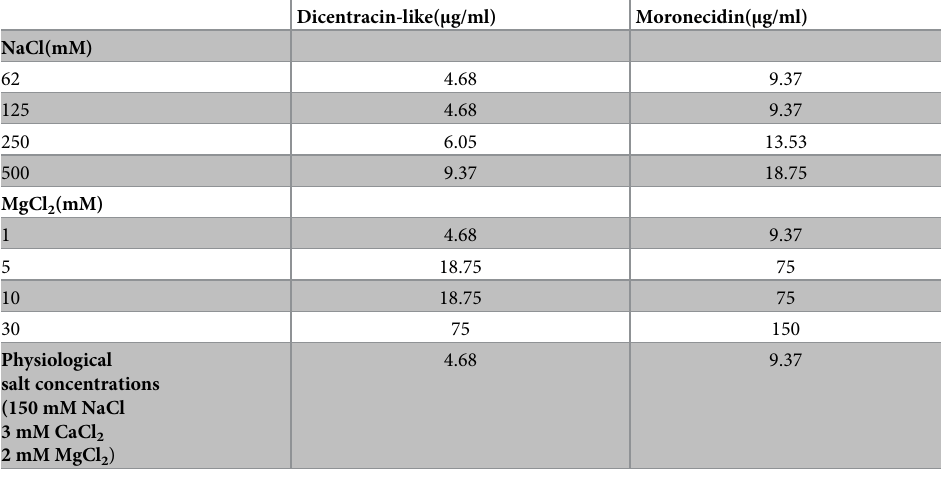
Table 3. Activity (MIC) of AMPs against E . coli in various salt